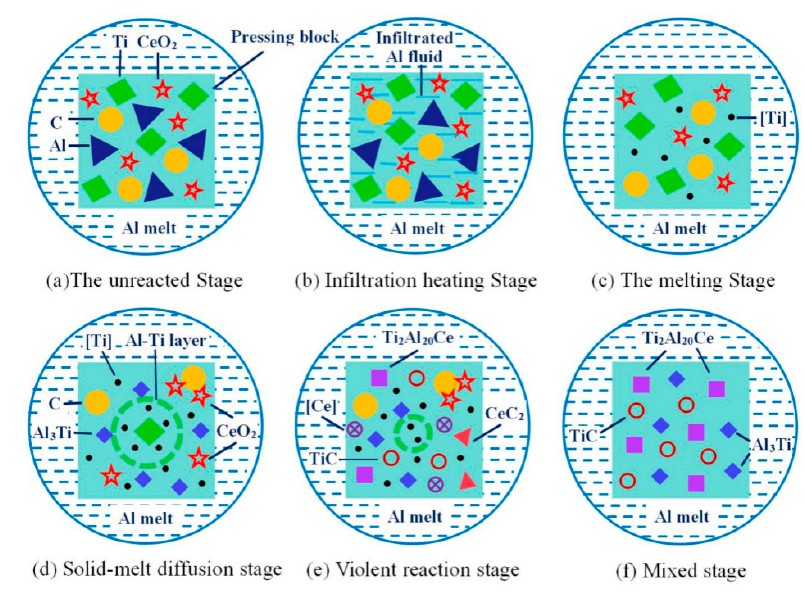
Figure 10. The dynamic model of the Al-Ti-C-Ce system.